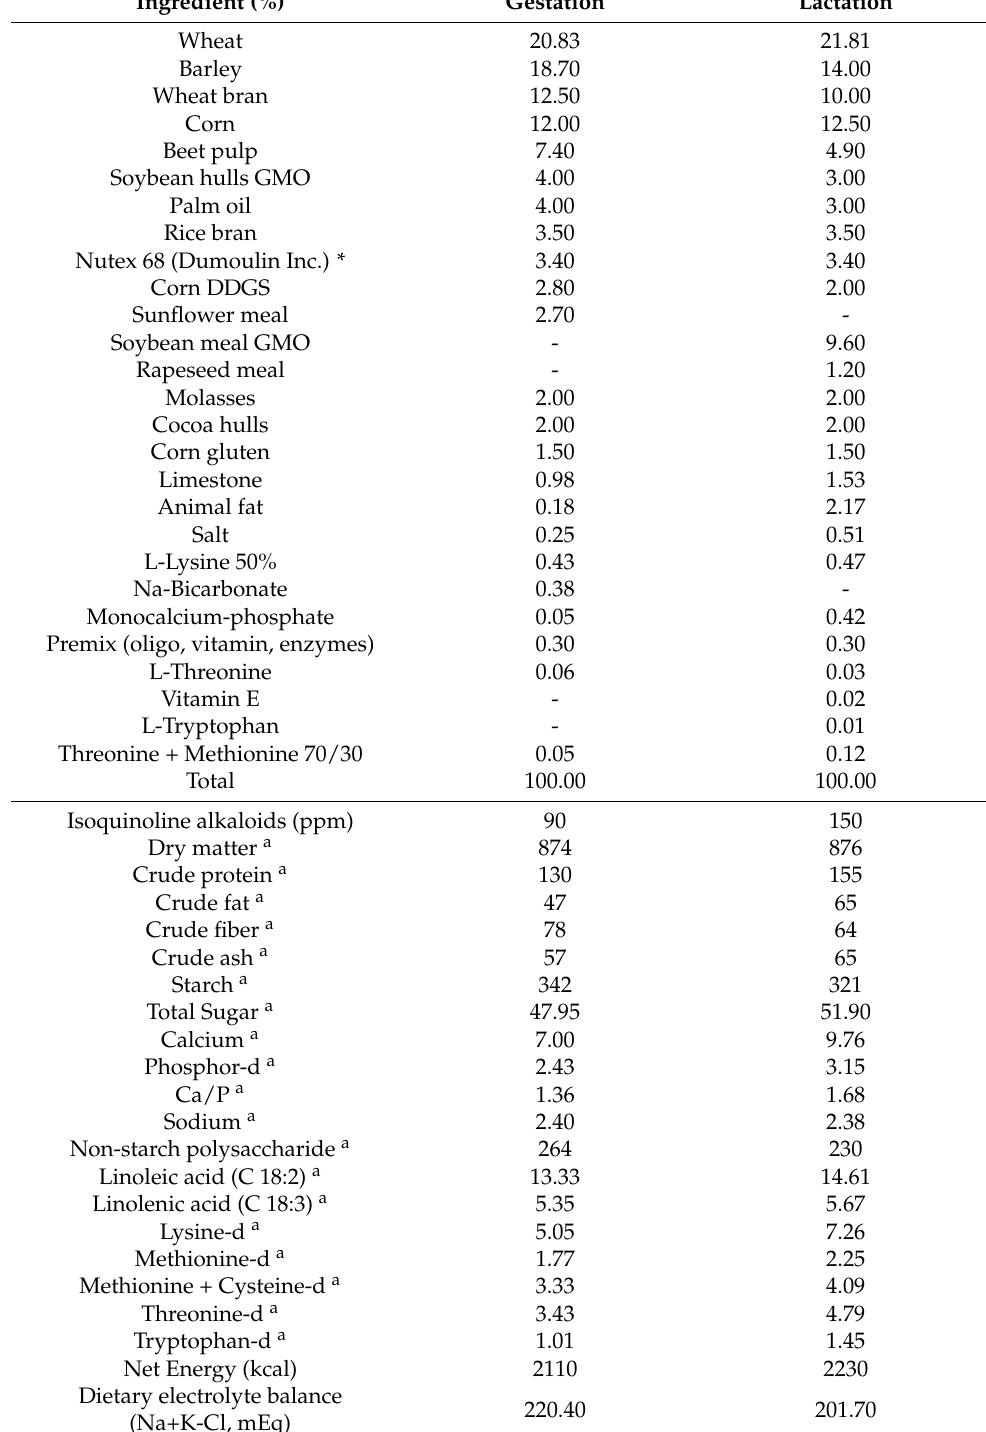
Table 1. Calculated composition of sows’ basal diet during the gestation and the lactation